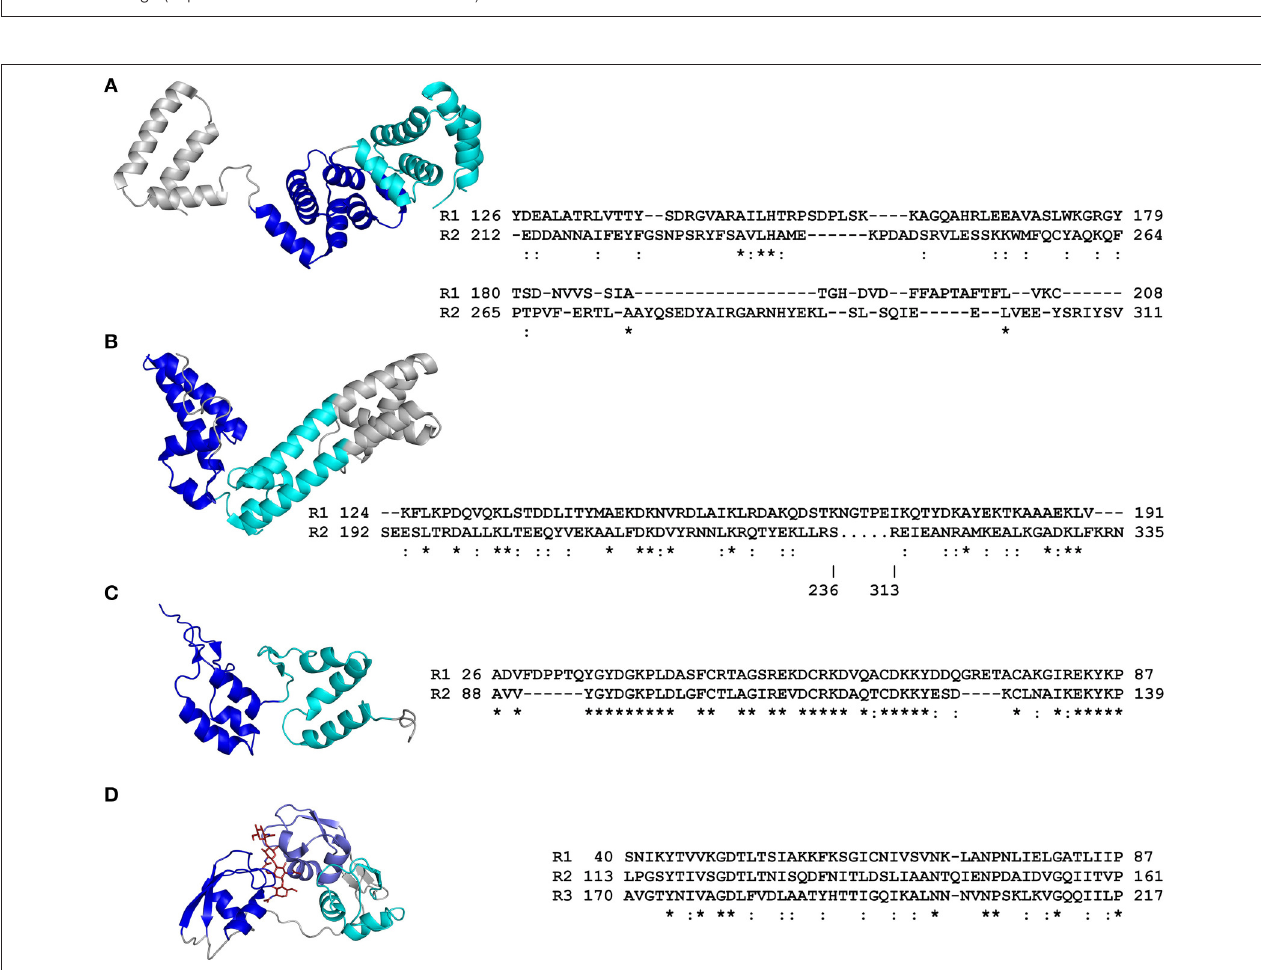
FIGURE 2 | Primary and tertiary structures of repeat domains from RCP effectors of plant-associated fungi and an oomycete. (A) Crystal structure of the ATR1 effector from the Arabidopsis thaliana oomycete pathogen, Hyaloperonospora arabidopsidis (Protein Data Bank [PDB] code 3RMR; Chou et al., 2011). (B) Crystal structure of the AvrM-A effector from the flax rust fungus, Melampsora lini (4BJN; Ve et al., 2013). (C) Nuclear magnetic resonance (NMR) structure of repeat units 1 and 2 from the candidate effector Cin1 of the apple scab fungus, Venturia inaequalis (2LHT; Mesarich et al., 2012). (D) Crystal structure of the Ecp6 effector from the tomato leaf mold fungus, Cladosporium fulvum . The lysin motif (LysM) repeat units 1 and 3 coordinate the binding of a single chitin tetramer by means of an inter-repeat domain groove (4B8V; Sánchez-Vallet et al., 2013). Structural coordinate files were downloaded from the Research Collaboratory for